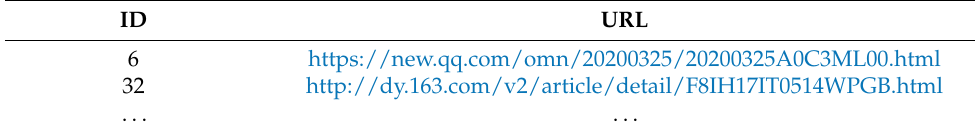
Table 3. Partial webpages of reliable epidemic data sources (accessed on 31 March